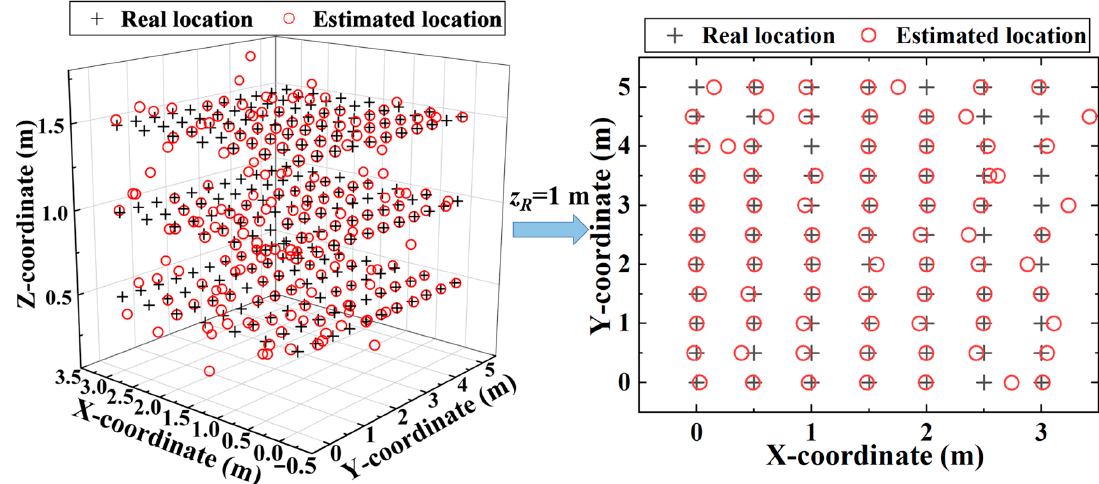
Figure 9. An example of 3D positioning results. ( θ = 20°). Figure 10. CDFs at the height of 1 m for: ( a ) 3D positioning errors; and ( b ) azimuthal errors. ( θ = 0°, 10°, and 20°).